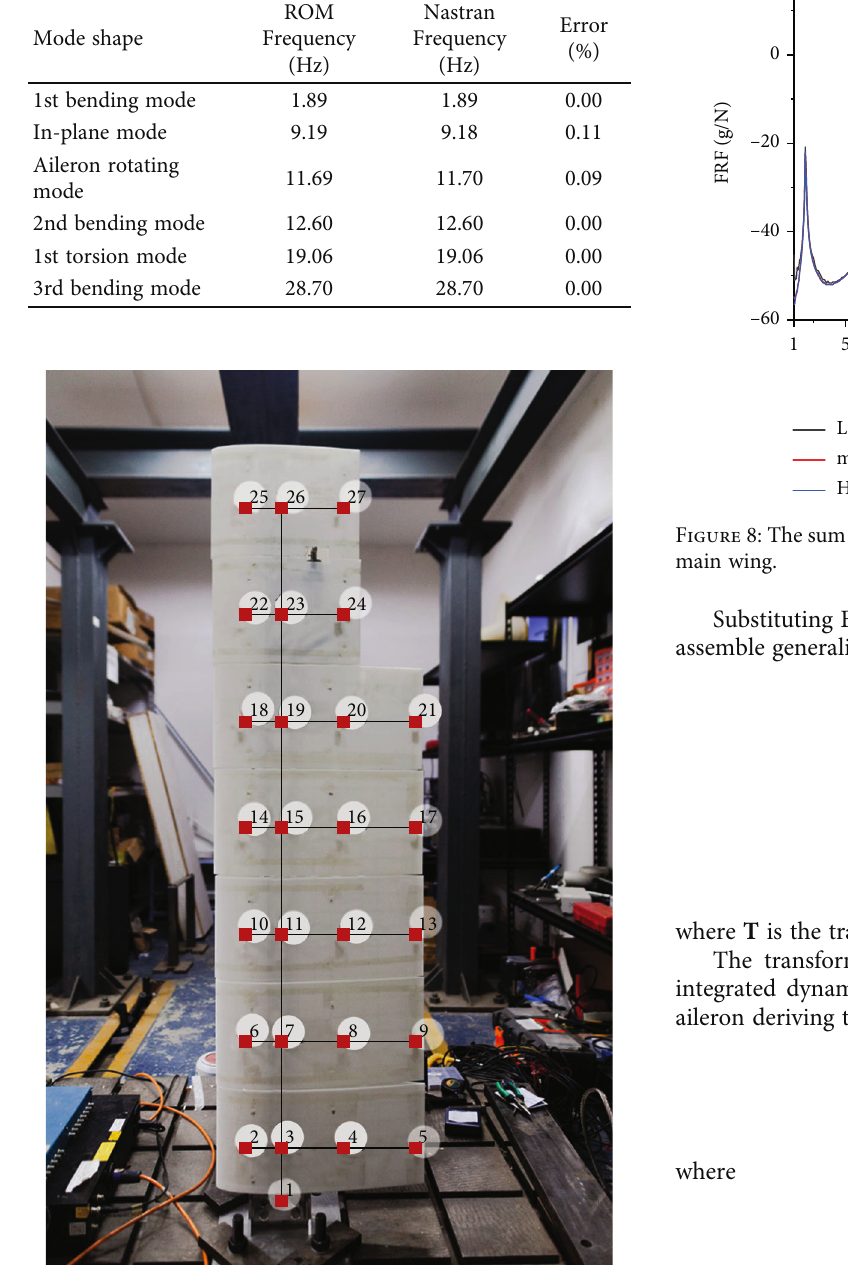
Table 1: Modal analysis of ROM and the original FE model. Mode shape